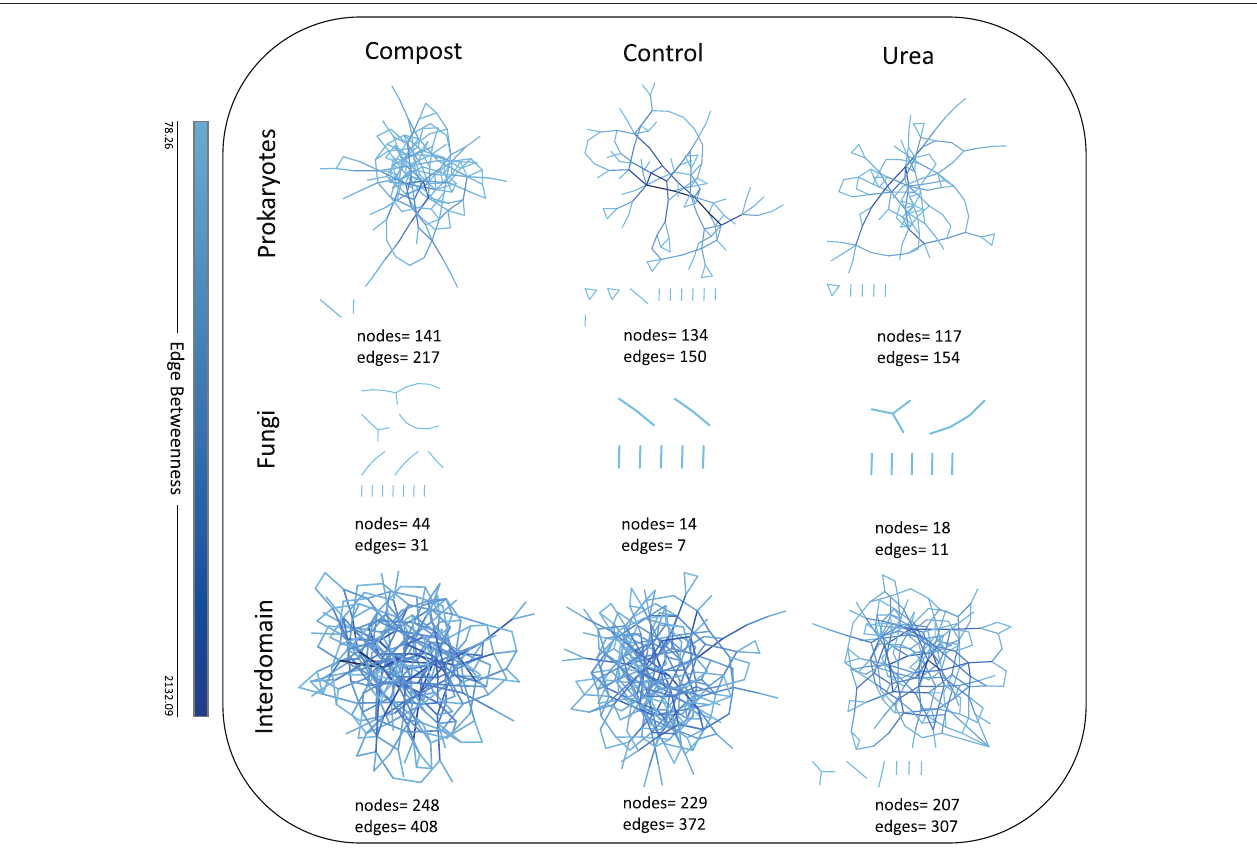
FIGURE 5 | Visual and quantitative measures of association networks for prokaryotes, fungi, and cross-domain across compost, urea, and control. Complexity of networks are represented here by nodes and edges, which may be inferred as predicted interaction, either positive or negative, and are colored by a measurement of edge betweenness, a component of network centrality (